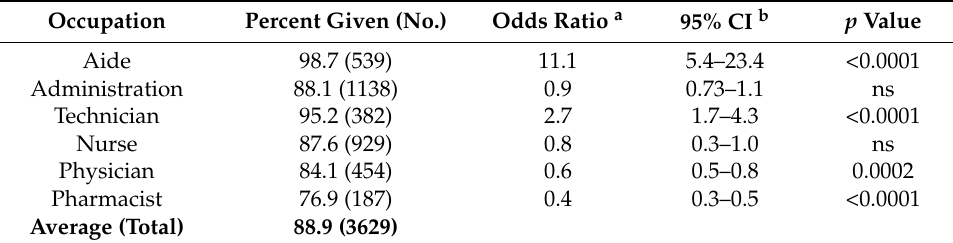
Table 3. Main reasons reported for not receiving influenza vaccinations by occupation.